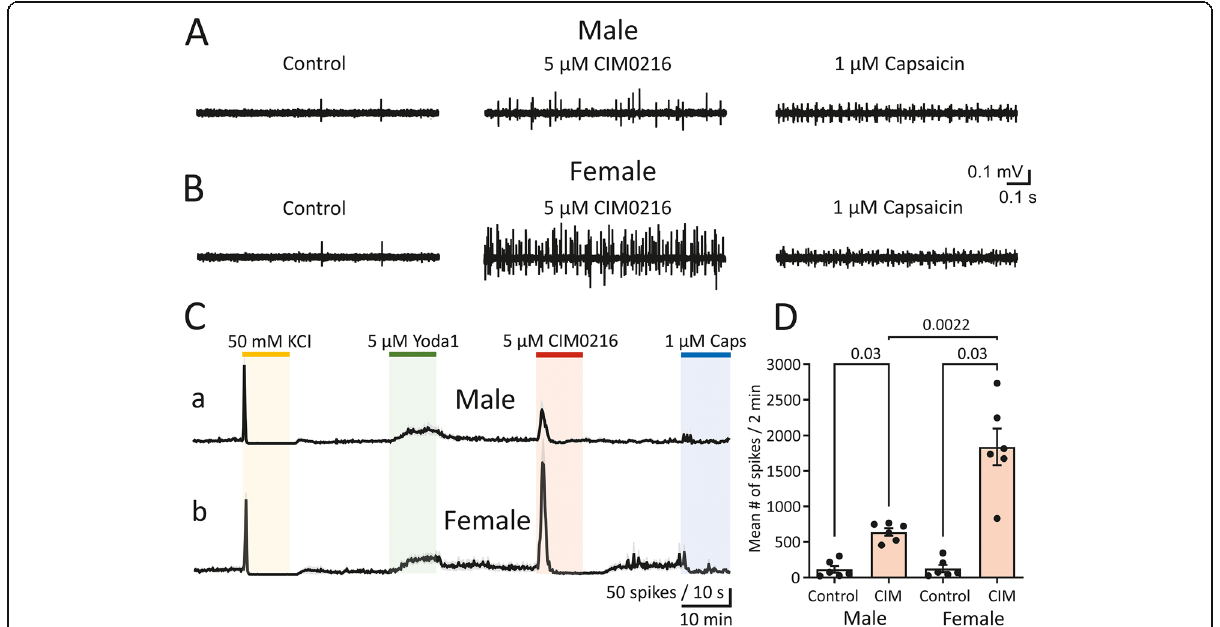
Fig. 3 Activation of trigeminal nerve terminals by CIM0216 in male and female mouse meninges. (A, B) Example traces of MUA in TG nerves of male (A) and female (B) mice recorded in the control condition (left), after application 5 μ M CIM0216 (middle) and after 1 μ M capsaicin (right). (C) Time course of spike frequency induced by application of 50 mM KCl, 5 μ M Yoda1, 5 μ M CIM0216 and 1 μ M capsaicin in males and females (mean ± SEM, 10-s bin size, n = 6 for both sexes). Notice the difference in the 2-min active phase of 5 μ M CIM0216 that was much more pronounced in females, and the subsequent silent time in males compared to overactivated firing recovery during the 20-min washout period in females. (D) Histograms show the mean number of nociceptive spikes during 10-min recordings in the control condition and after application of 5 μ M CIM0216 in males (mean ± SEM, n = 6, p = 0.03, Wilcoxon signed-rank test) and females (mean ± SEM, n = 6, p = 0.03, Wilcoxon signed-rank test). Notice the sex difference in firing when 5 μ M CIM0216 was applied ( p = 0.0022, Mann – Whitney U